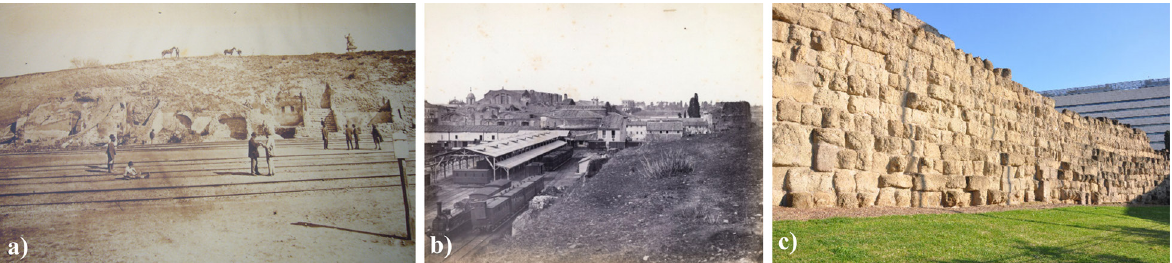
Fig. 3. a. Monte della Giustizia before the demolition, 1862 (image by lalupa, Wikimedia Commons). b. On the right side of Termini Station: what remains of Monte della Giustizia, one year before its final demolition, 1868 (Photo: Raccolta Parker). c. the Servian Walls outside the station, as they appear today after having been extracted from debris (Photo: A. Pica,